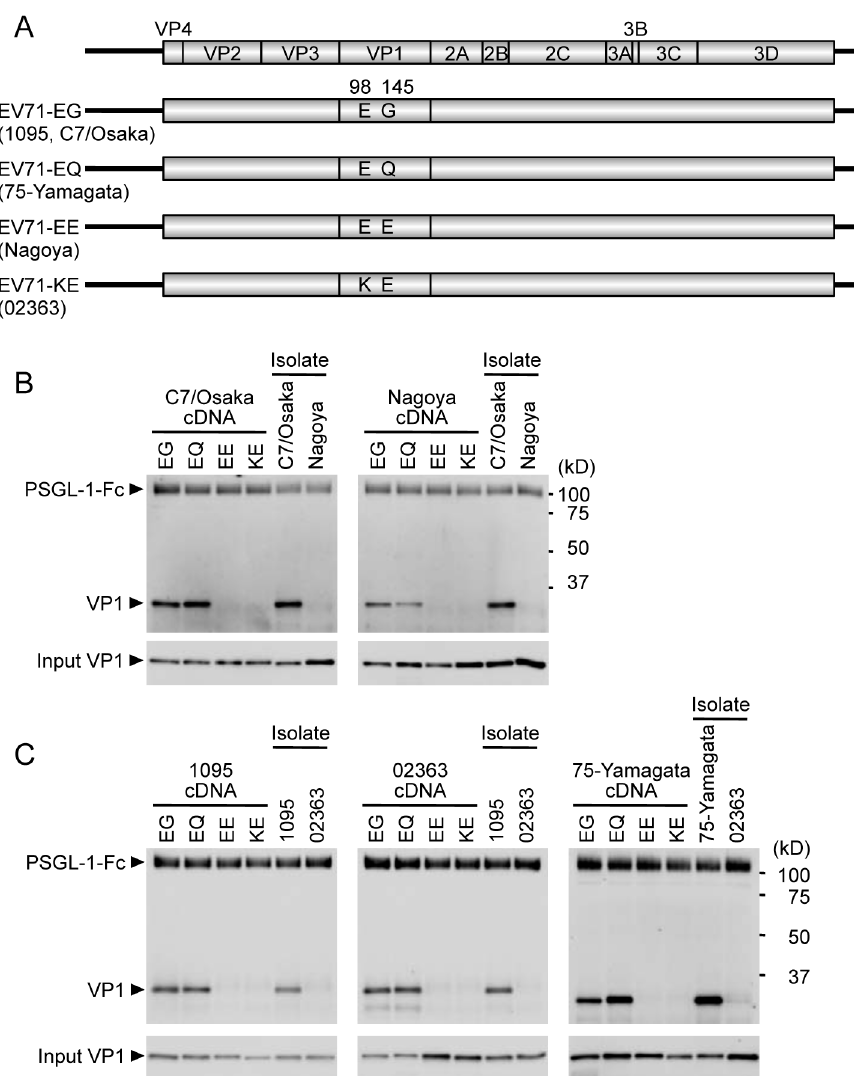
Figure 1. Co-precipitation analysis of EV71 mutants with soluble PSGL-1-Fc. (A) Scheme of EV71 constructs with amino acid substitutions at VP1-98 and VP1-145. The original strains, which have the indicated amino acids at VP1-98 and VP1-145, are indicated in parentheses. (B, C) The co- precipitation of EV71 and PSGL-1-Fc was detected by western blotting using anti-VP1 mAb and an anti-Fc antibody. EV71-PB (C7-Osaka, 1095, 75- Yamagata) and EV71-non-PB (Nagoya and 02363) isolates (not derived from cDNA) were used as positive and negative controls for binding to PSGL-1- Fc, respectively. The data are representative of three independent experiments. (B) EV71 strains of genogroup B. (C) EV71 strains of genogroup C.